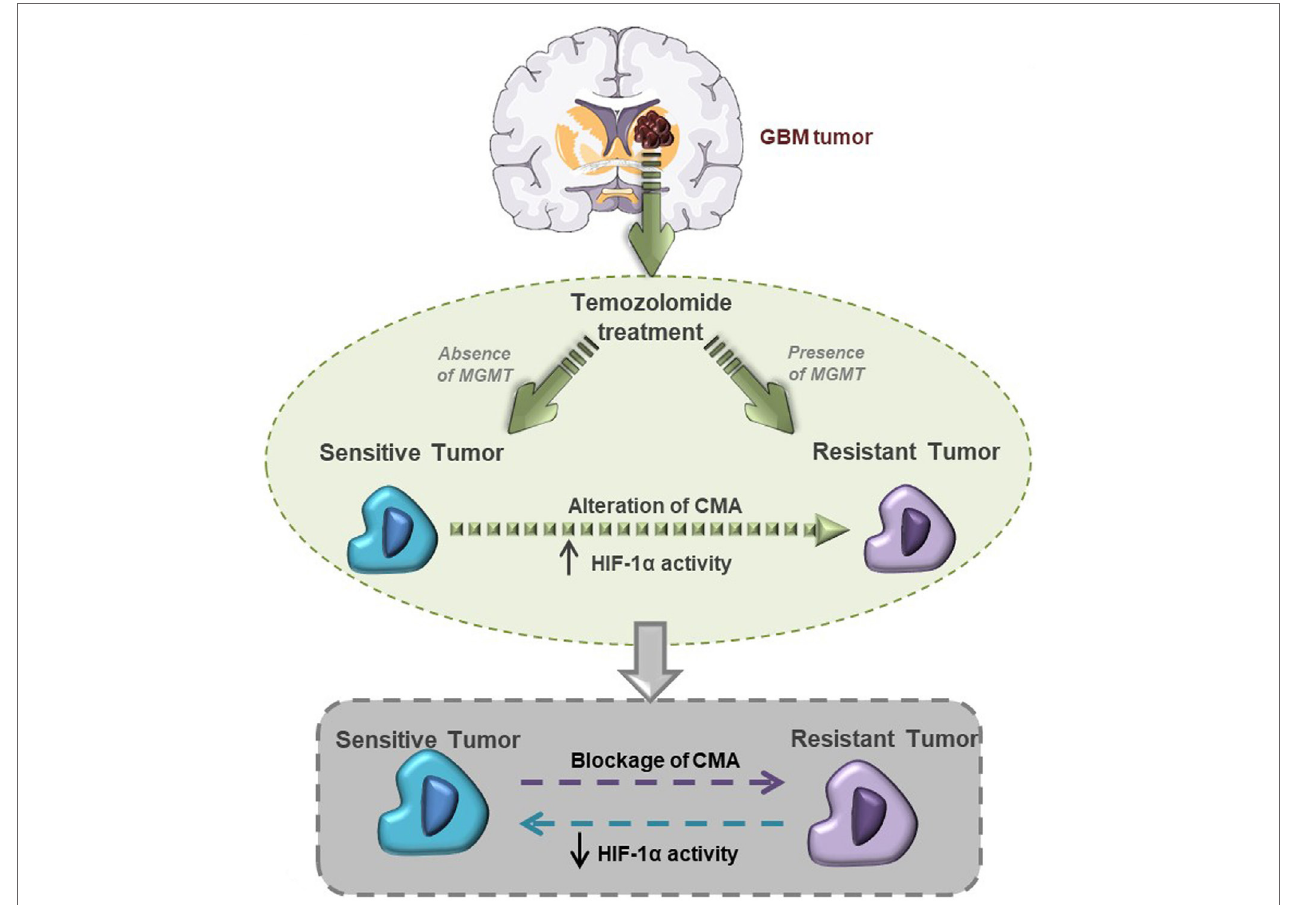
FigUre 6 | This graphical abstract explains hypoxia-inducible factor (HIF)-1 α /chaperone-mediated autophagy (CMA) relation with glioblastoma responsiveness to temozolomide